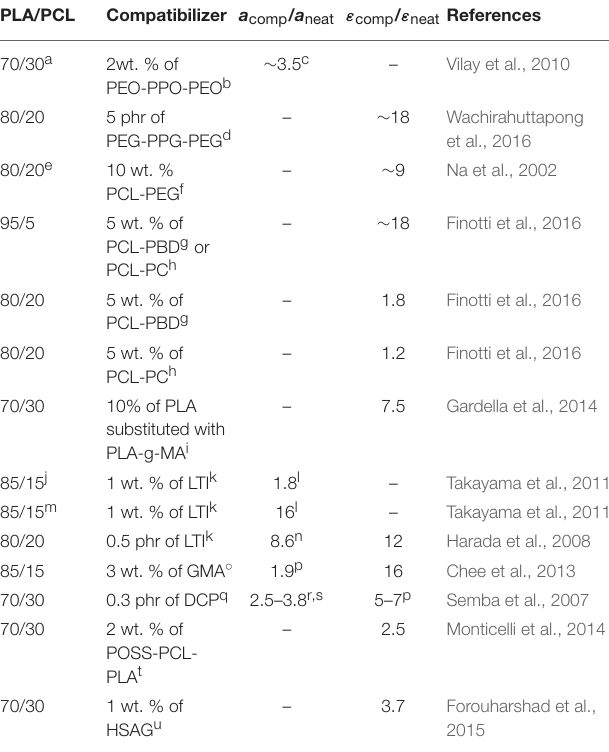
TABLE 2 | Ratios of toughness, a comp / a neat , and elongation at break, ε comp / ε neat , of compatibilized and neat blends for various compatibilizers.